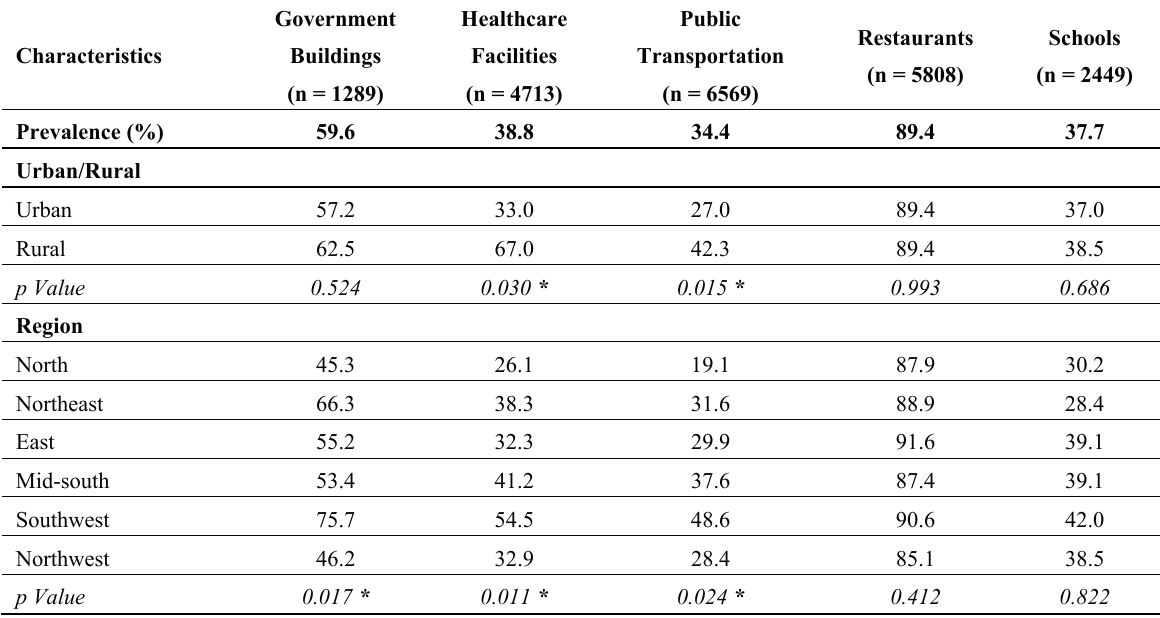
Table 4. Prevalence of viewing smoking in various public